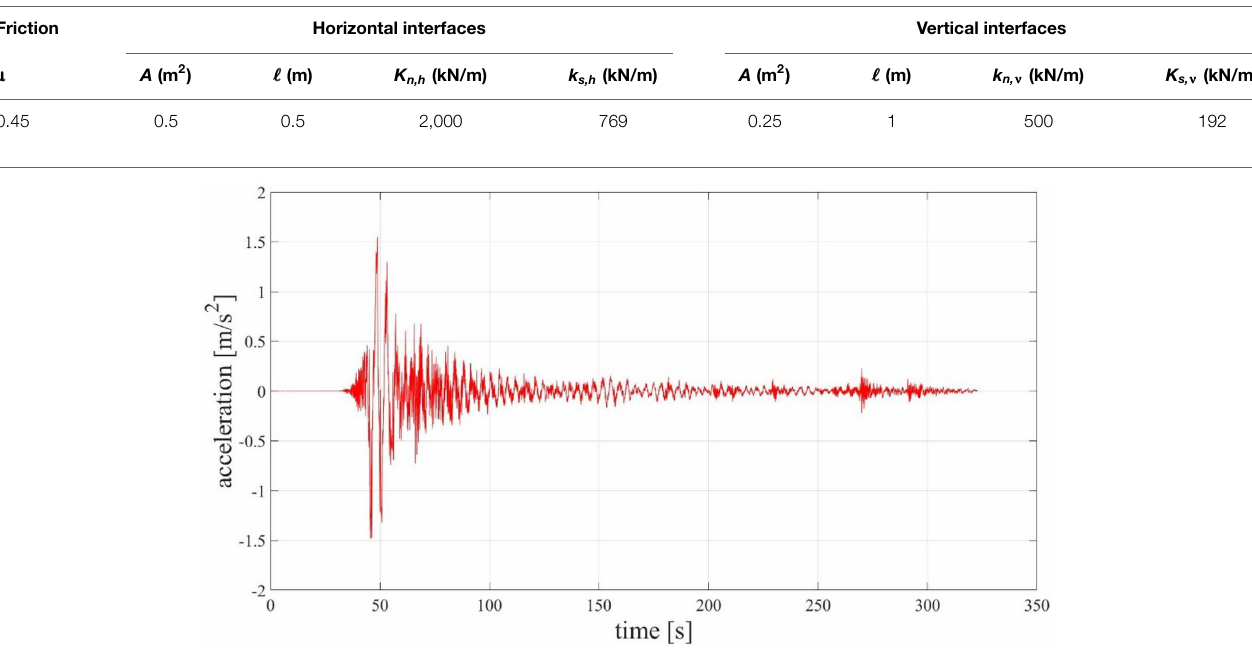
FIGURE 9 | Seismic record used in the